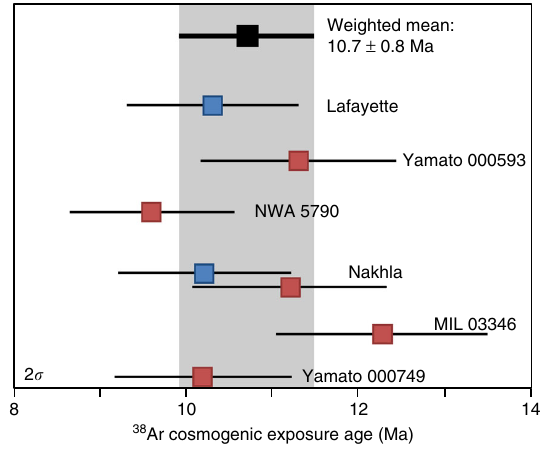
Fig. 3 Cosmogenic exposure dates for the nakhlites. 38 Ar cosmogenic exposure ages overlap within uncertainty, which is consistent with all of the nakhlites being sourced from the same impact. Blue data points were analysed at Lawrence Livermore, and red data points were analysed at SUERC. The weighted mean cosmogenic exposure age is 10.7 ± 0.8 Ma (2 σ , full external uncertainty, bold text and grey shaded area ), which represents the timing of the nakhlite impact event on Mars